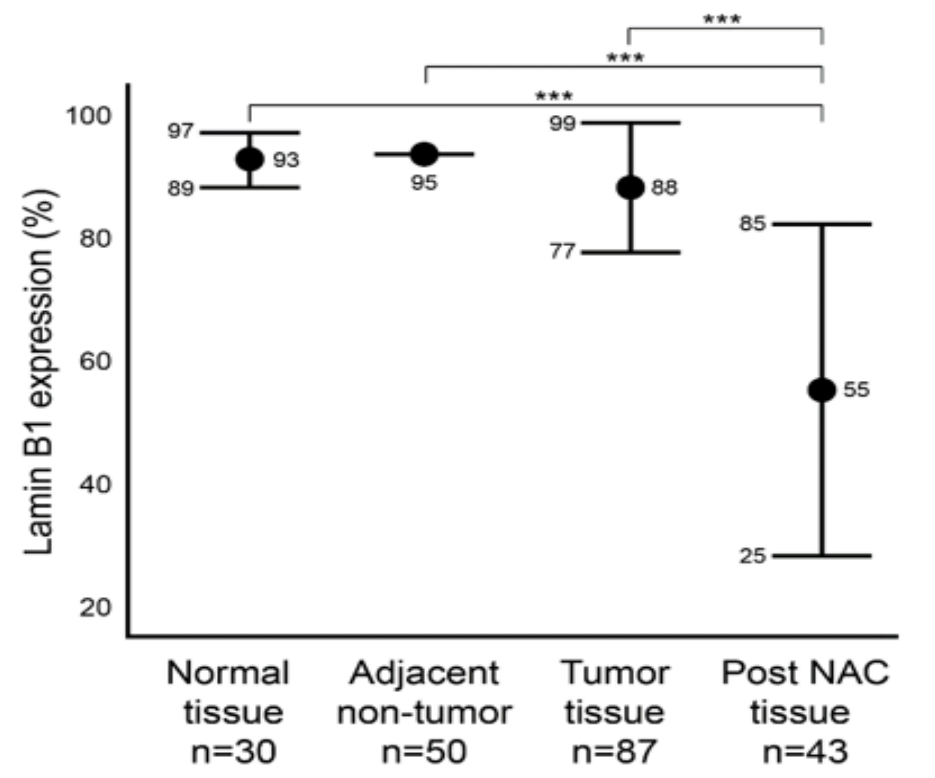
Figure 2. Comparison of lamin B1 protein expression levels within normal, adjacent non-tumor, tumor (not exposed to NAC), post NAC breast formalin-fixed paraffin-embedded (FFPE). Error bars show mean and ± 1 SD. Statistical differences were calculated using Mann-Whitney